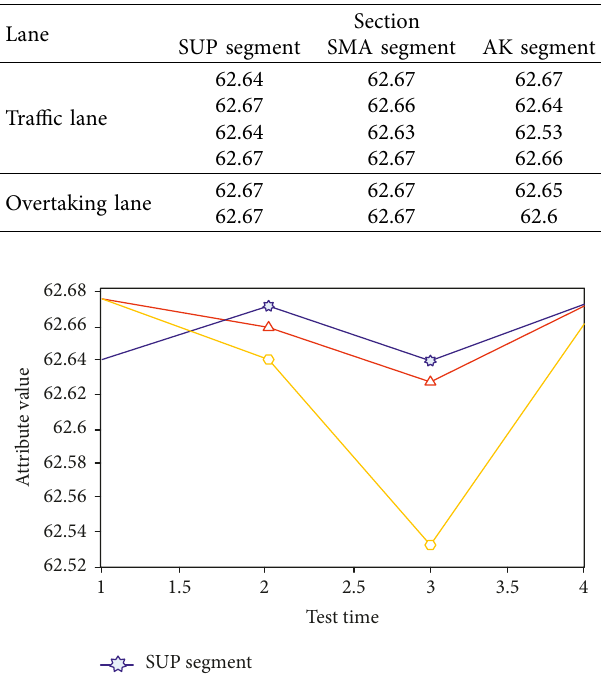
Table 1: PCI indicators (taking rutting into account).